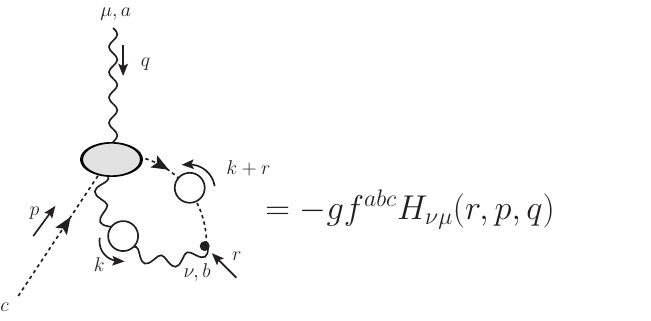
Figure 2. Diagrammatic definition of the ghost–gluon scattering kernel, H νµ ( r , p , q ) . At the tree level, H 0 νµ = g νµ